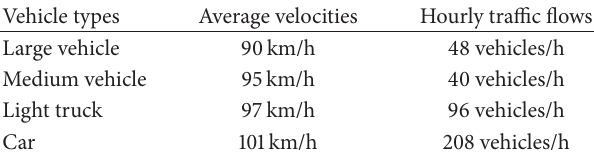
Table 4: Vehicle velocities and hourly traffic flows.